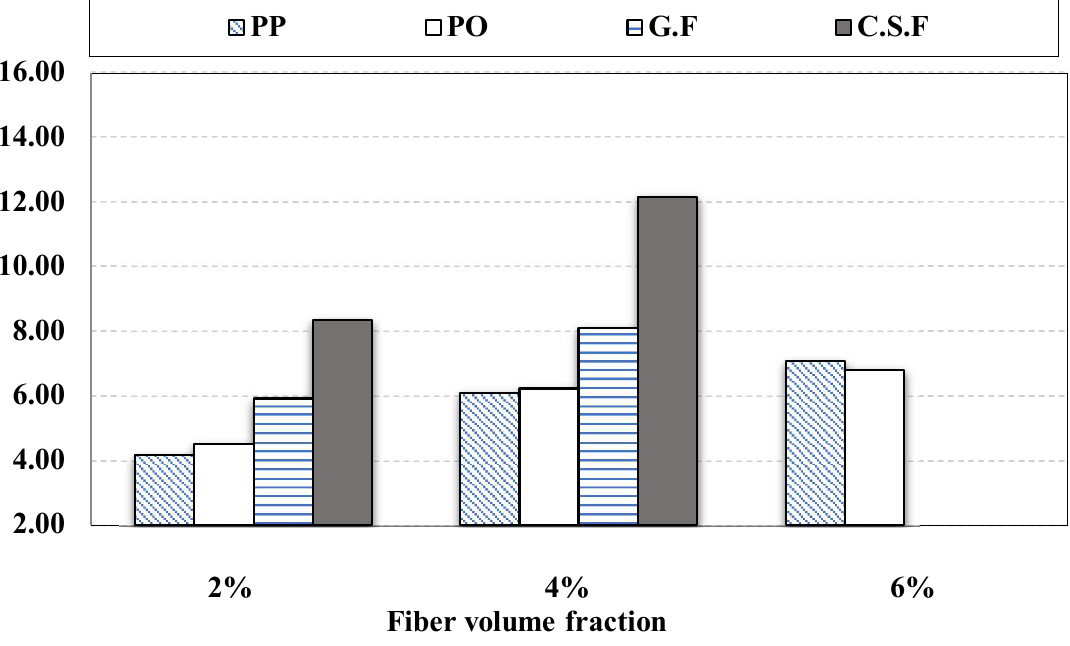
Figure 11. Flexural strength at 7 days due to fiber type change.